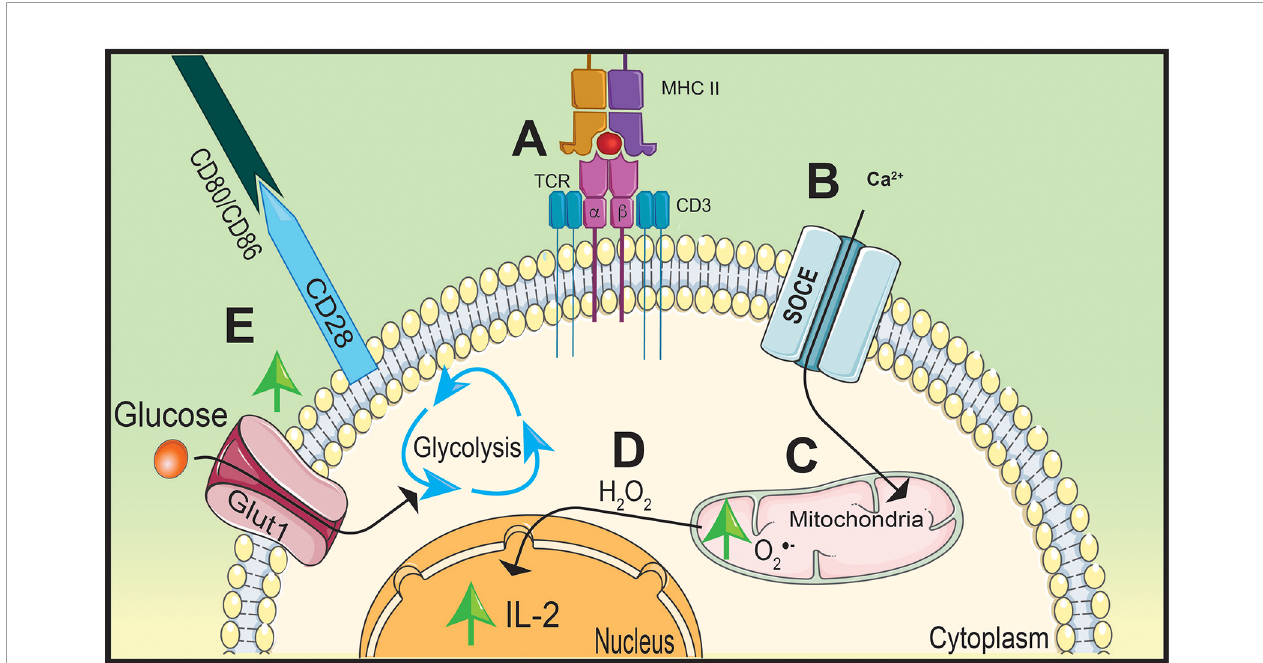
FIGURE 2 | Stimulation of TCR and CD28 causes a metabolic shift in naïve CD4 T cells. T cell receptor (TCR) stimulation by peptide presented on major histocompatibility complex-II (MHC-II) (A) will increase calcium (Ca 2+ ) entry into the cytoplasm through store operated calcium entry (SOCE) channels (B) increasing mitochondrial-derived superoxide ( O · − 2 ) generation (C) . Oxidative phosphorylation (OxPhos) will promote interleukin (IL)-2 expression by hydrogen peroxide (H 2 O 2 ) signaling (D) . Simultaneously, CD28 will upregulate Glut1 expression on the cell membrane increasing glucose uptake shifting metabolism away from OxPhos to glycolysis to support rapid proliferation (E)